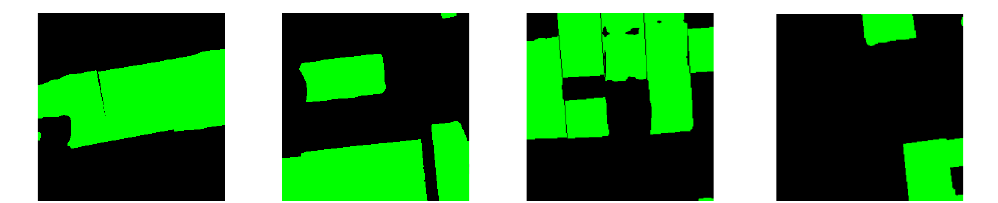
Figure 9. Building extraction results of different deep learning models with the rural Weinan building dataset. ( a – d ) Four images randomly selected to show the test results. SegNet, UNet, Deeplabv3+, AGs-Unet, MAP-Net, ARC-Net, and EDSANet, respectively, are represented by the building extraction results from the four groups of comparison experiments. Green represents the buildings and black represents the background. In the ground truth, red represents the buildings and black represents the background.